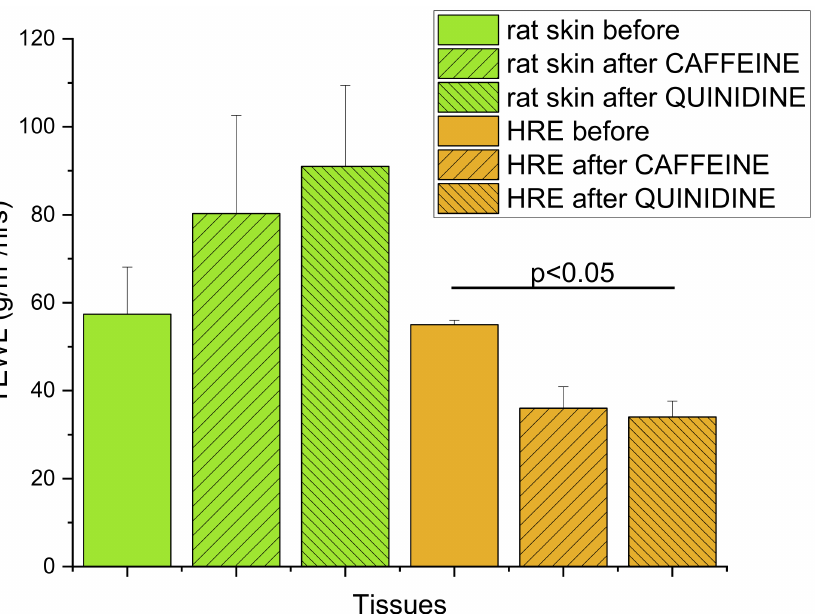
Figure 8. Transepidermal water loss (TEWL) as the indicator of dermal barrier function, determined in (1) rat skin samples after 10 tape strippings before any kind of treatment or after 5h exposition to 2% caffeine or quinidine cream in the skin-on-a-chip device; (2) in EpiDerm TM HRE tissues before any kind of treatment or after 5 h exposition to 2% caffeine or quinidine cream in the skin-on-a- chip device. N = 11 for the skin before, and N = 3 − 4 for the other groups. Data are expressed as means ±